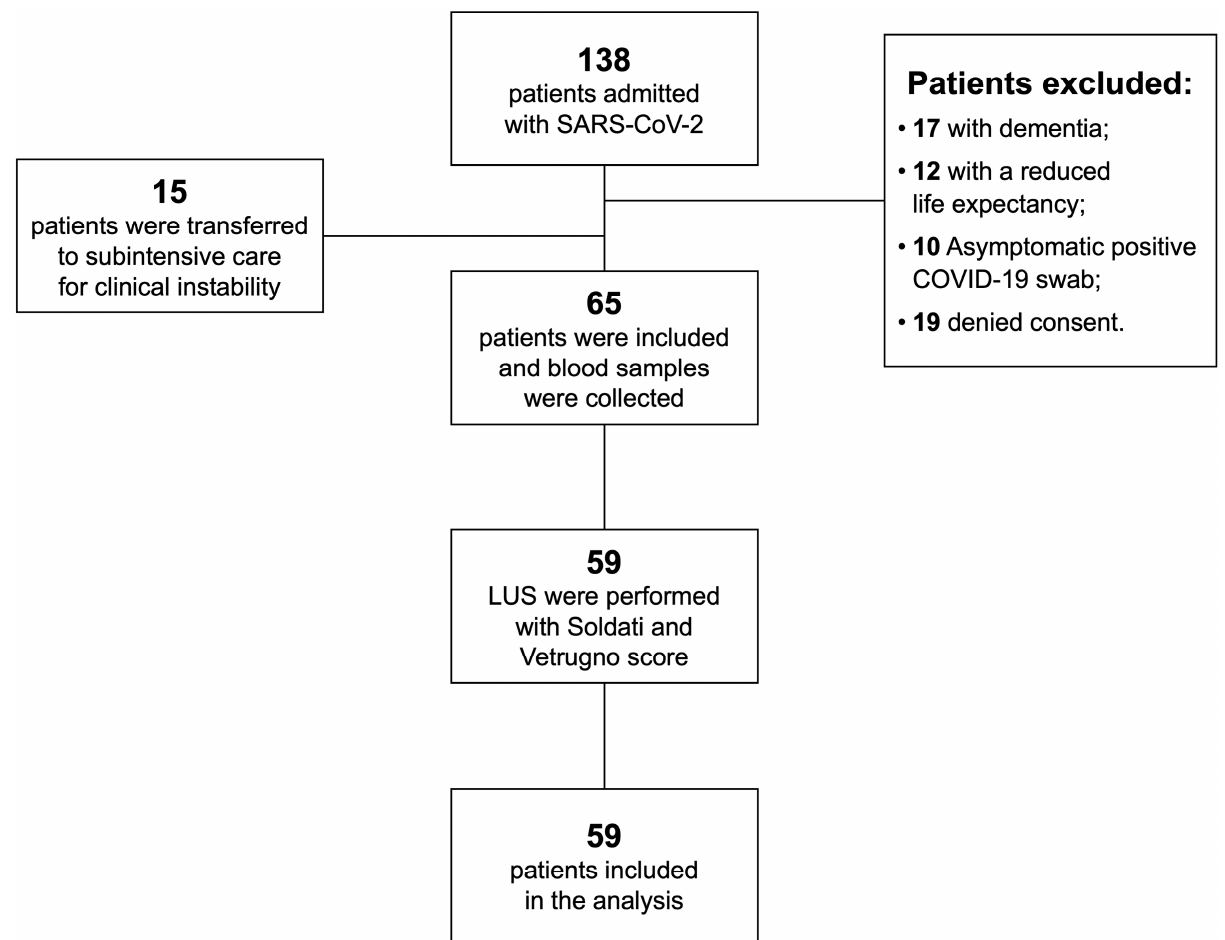
Figure 1. Flow diagram of the enrolment of the study population.